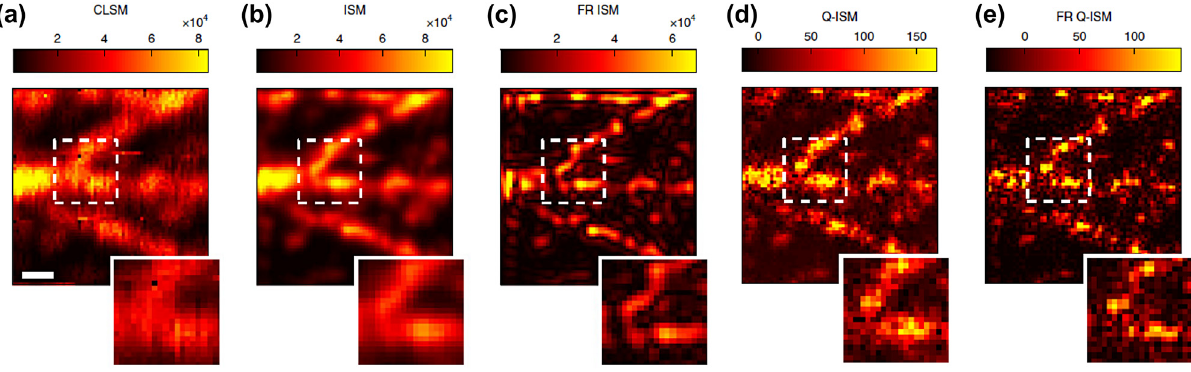
Figure 19: Microtubule imaging using quantum